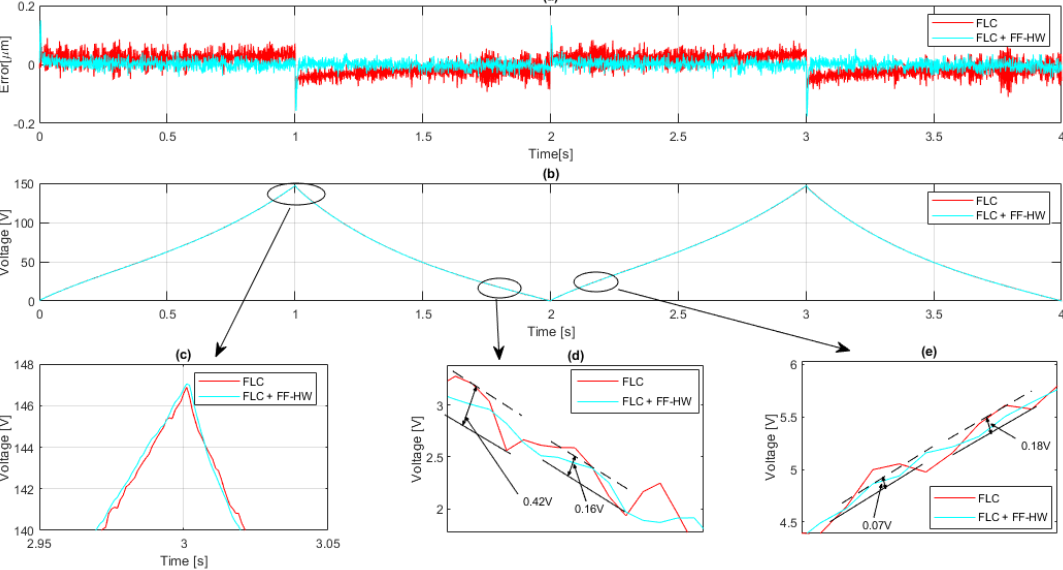
Figure 8. Comparison of error and control signal between FLC and FLC with FF-HW. ( a ): Error; ( b ): Control signal; ( c ): Control signal at the top peak; ( d ): Control signal near the lower peak; and, ( e ): Control signal after the lower